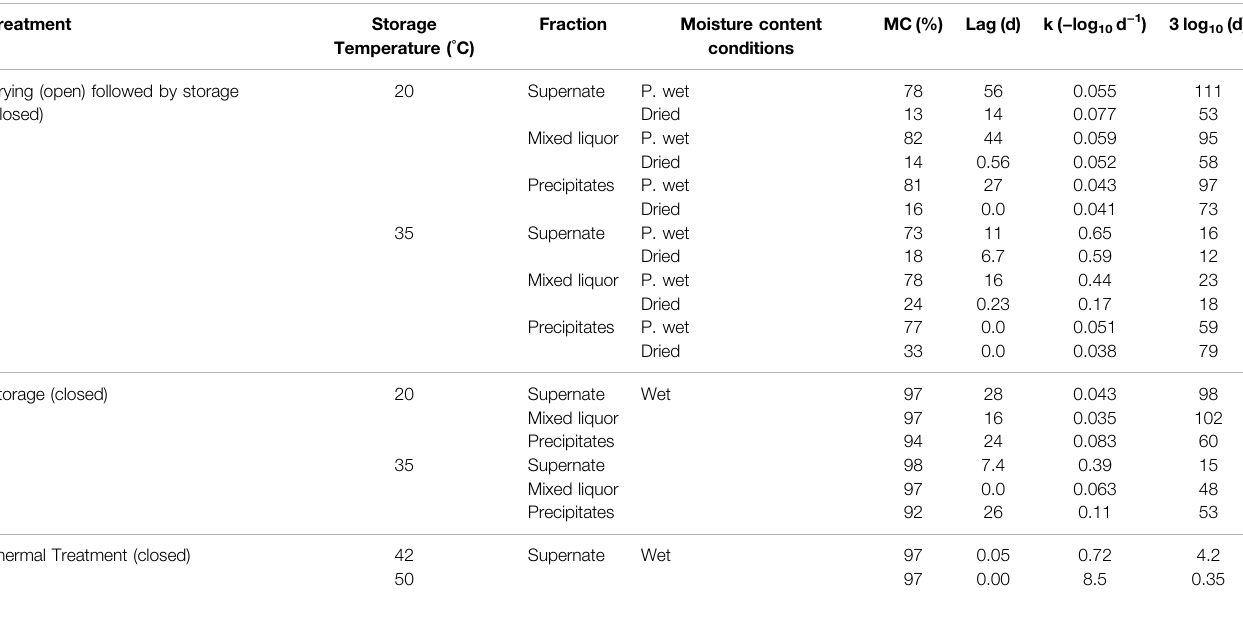
TABLE 4 | Ascaris egg inactivation parameters: lag phase (days); inactivation rate constant k (-log 10 d − 1 ); time required for a 3 log 10 reduction in egg viability (days), derived from Eq. 1 , 2 , for Ascaris eggs subjected to the different drying, storage and thermal treatments. Wet conditions had > 90% MC, Partially wet (P. wet) condition had 73 – 82% MC (no free liquid on the surface); and Dried conditions had 13 – 33%